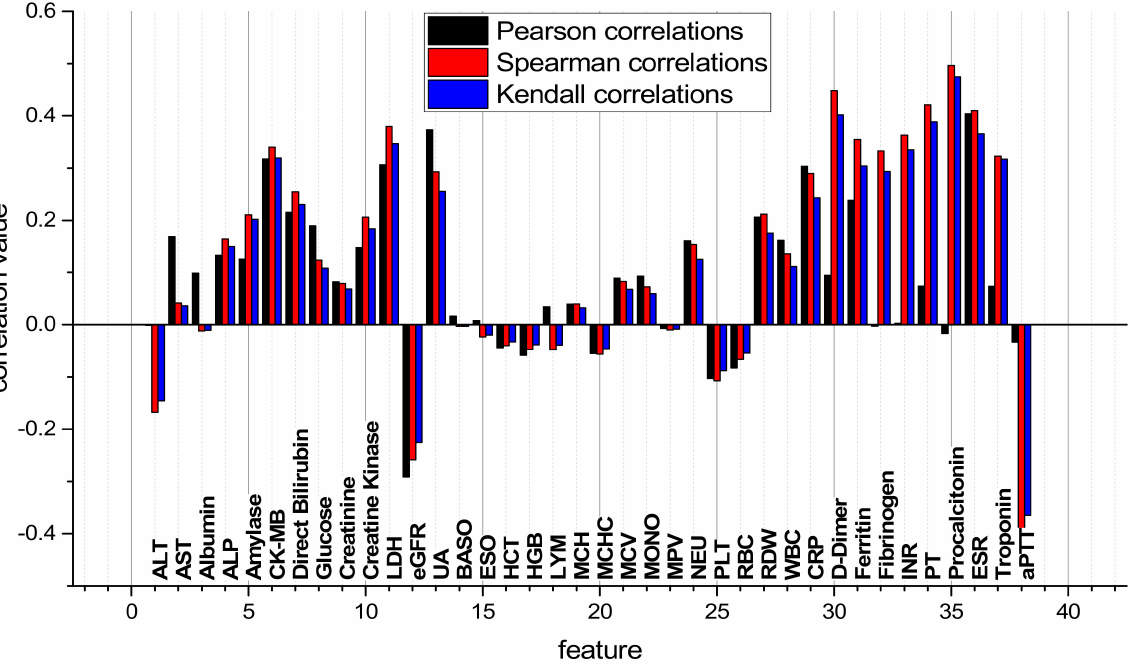
Figure 1. Pearson, Spearman and Kendall correlations of the SARS-CoV-2-RBV3 dataset for COVID-19 mortality-feature